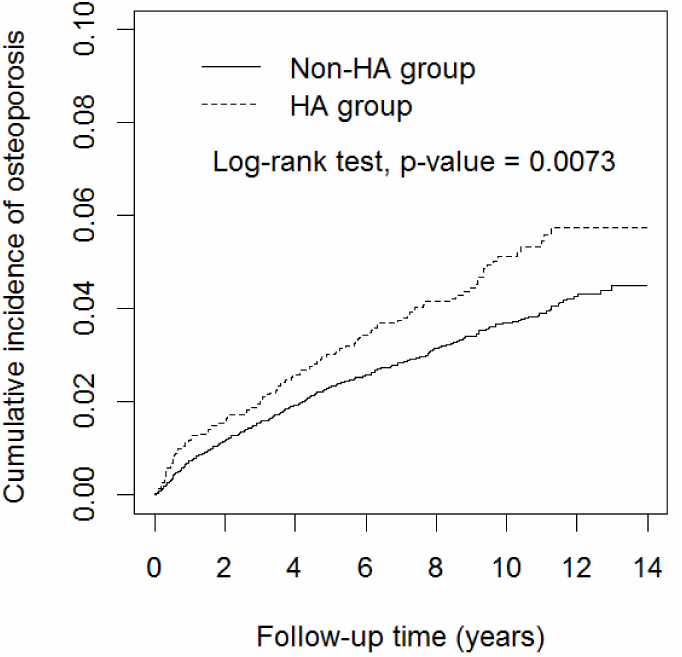
Figure 2. Cumulative incidence curves of osteoporosis for groups with and without hemolytic anemia. Abbreviation: HA, hemolytic